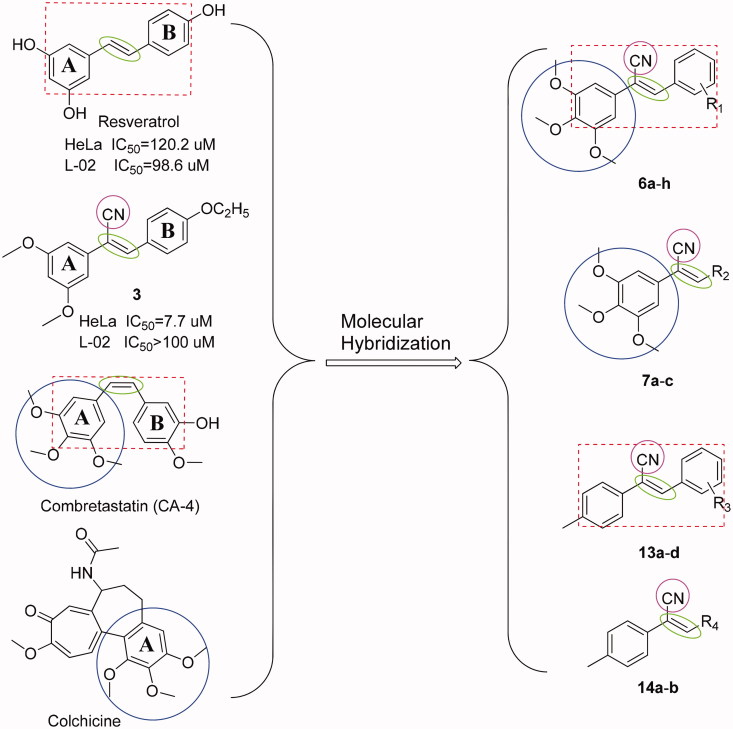
The structures of resveratrol, compound 3, CA-4, colchicine, and the design of target compounds 6a-h, 7a-c, 13a-d, and 14a-b.